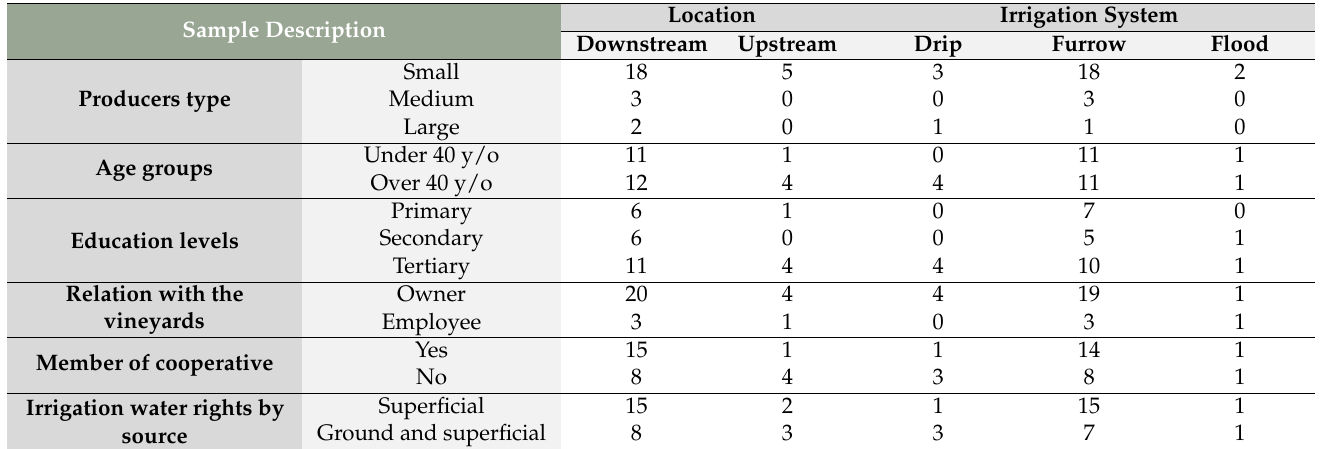
Table 1. Location, irrigation system and socio-economic characteristics of grape producers inter- viewed and their farms ( n =